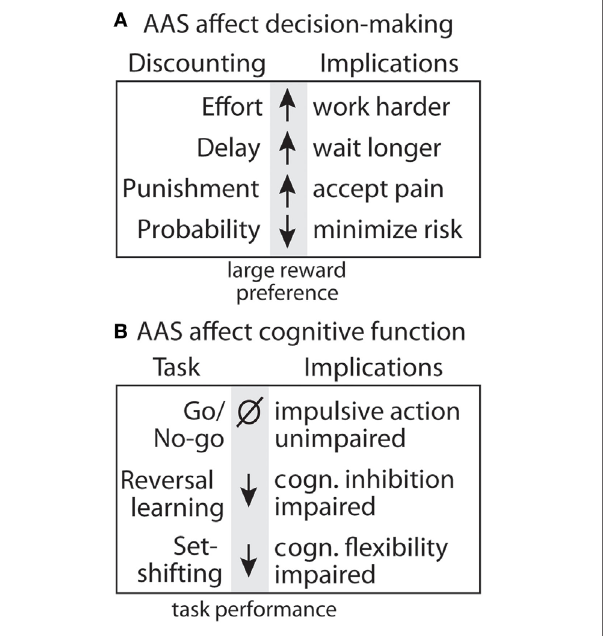
FiGURe 8 | Summary of effects of anabolic­androgenic steroids (AAS) on decision making and cognitive function. (A) Testosterone effects on discounting behavior for effort (190), delay (191), punishment (192), and uncertainty (190). (B) Testosterone effects on cognitive function and motor impulsivity in the go/no­go task (192), cognitive inhibition in the reversal learning task, and cognitive flexibility in the set­shifting task